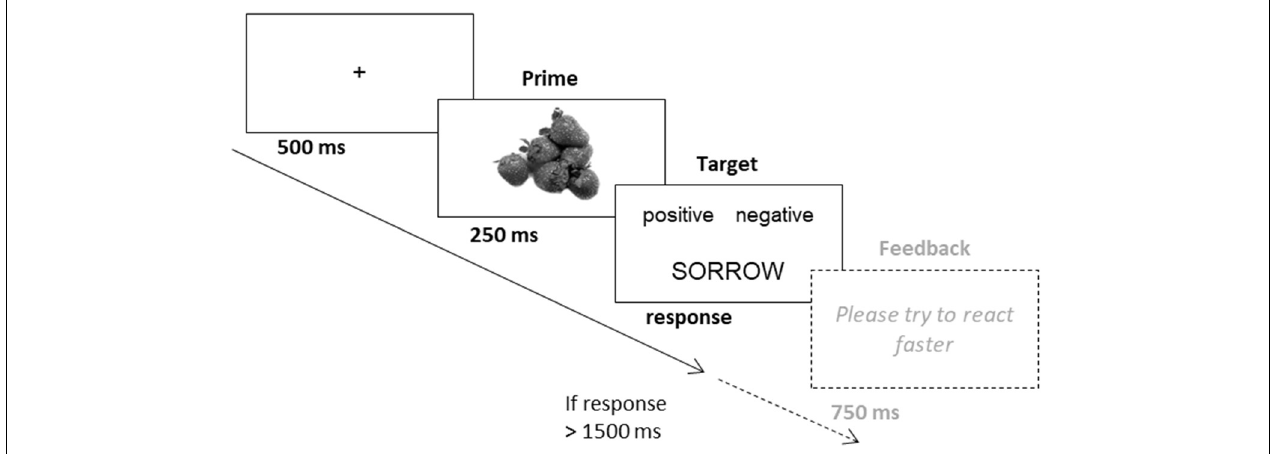
FIGURE 3 | Example of an incongruent trial with a positive prime and a negative target in the evaluative priming task in Study 3.